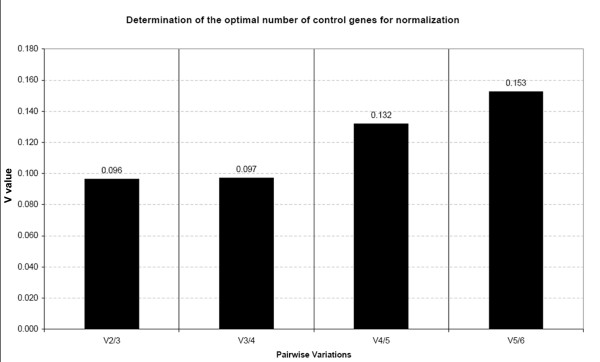
Determination of the optimal number of reference genes for data normalization. Bar values indicate the magnitude of change in the normalization factor after the inclusion of an additional reference gene. GeNorm authors' suggest that V > 0.15 should be considered as the threshold to include an extra reference gene into the assay.